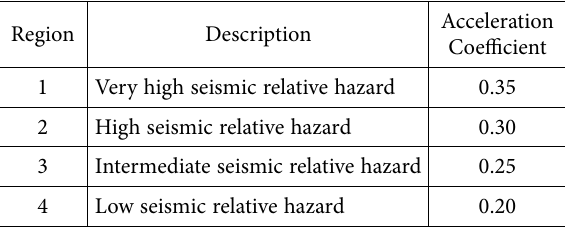
Table 1. Acceleration coefficient (A) (IIEES 2012)